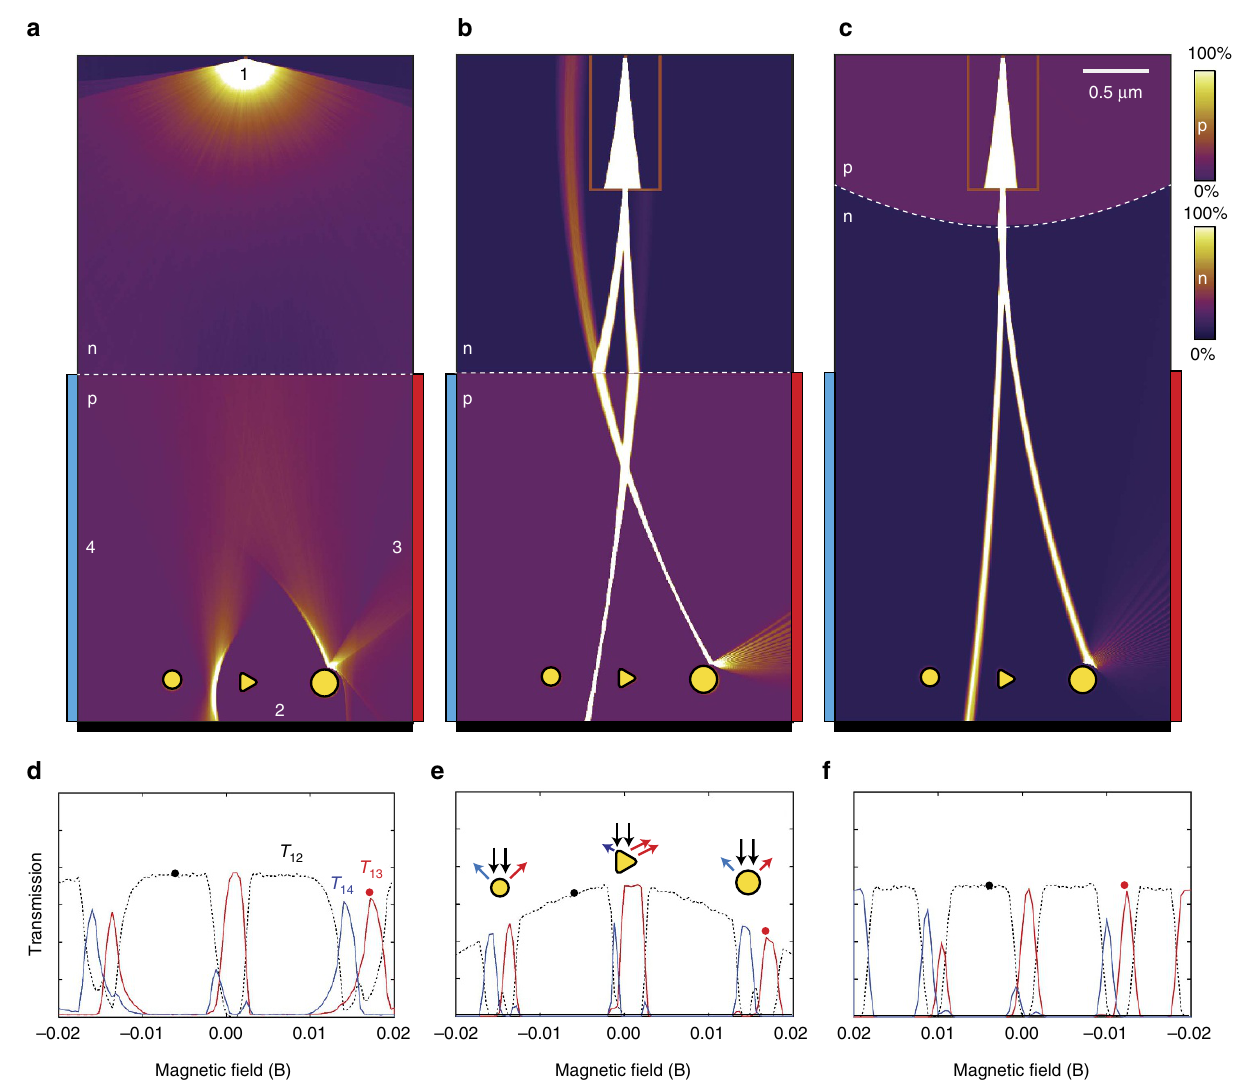
Figure 3 | Imaging with Dirac fermions. Current density maps of three DFM microscope configurations, ( a ) Veselago, ( b ) Pinhole/Veselago and ( c ) Pinhole/Parabolic lens. In each case, the current density for two different magnetic fields are overlaid, indicated with black and red dots in panels below. Colour scales ranging from 0% (zero current density) to 100% (high current density) are used to visualize zones with different carrier polarity p and n. ( d – f ) The dashed black curves show the transmissions from electrode 1 to the back electrode 2, whereas red and blue curves represent carriers exiting at the right (3) and left (4) electrodes, respectively, as also indicated in a . The magnetic field axis is intentionally reversed to correctly align the red and black dots in f with the simulated electron beams in c . The transmission images from the three target objects are distinctly different, with the spherical objects leading to relatively symmetric peaks and the triangular object giving rise to a sharp transmission peak from reflection at the left corner of the triangle, and a broader peak or plateau corresponding to reflection from the flat, right-hand side of the triangle. Of the three selected configurations, the configuration a exhibits the largest aberration and image distortions, configuration b the sharpest features due to highly focused beam, whereas c maintains a constant transmission current across the image field. The three configurations are analysed with respect to beam profile, angular distribution and linearity with respect to the magnetic field in Supplementary Note 1 and Supplementary Fig. 1. The imaging is showing during operation in Supplementary Movie